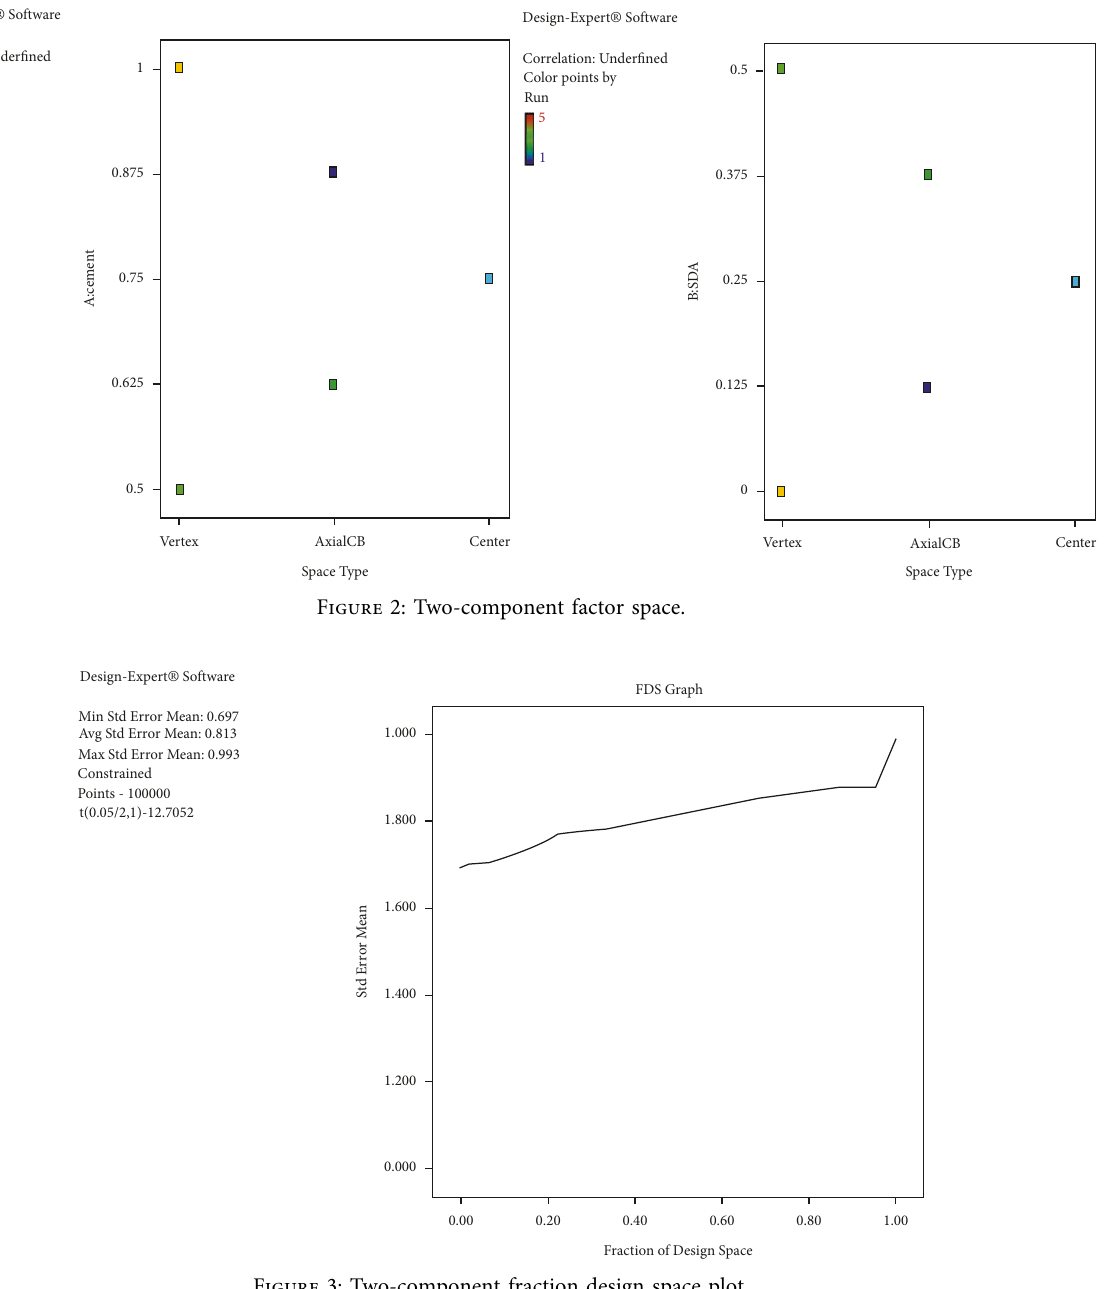
Figure 3: Two-component fraction design space